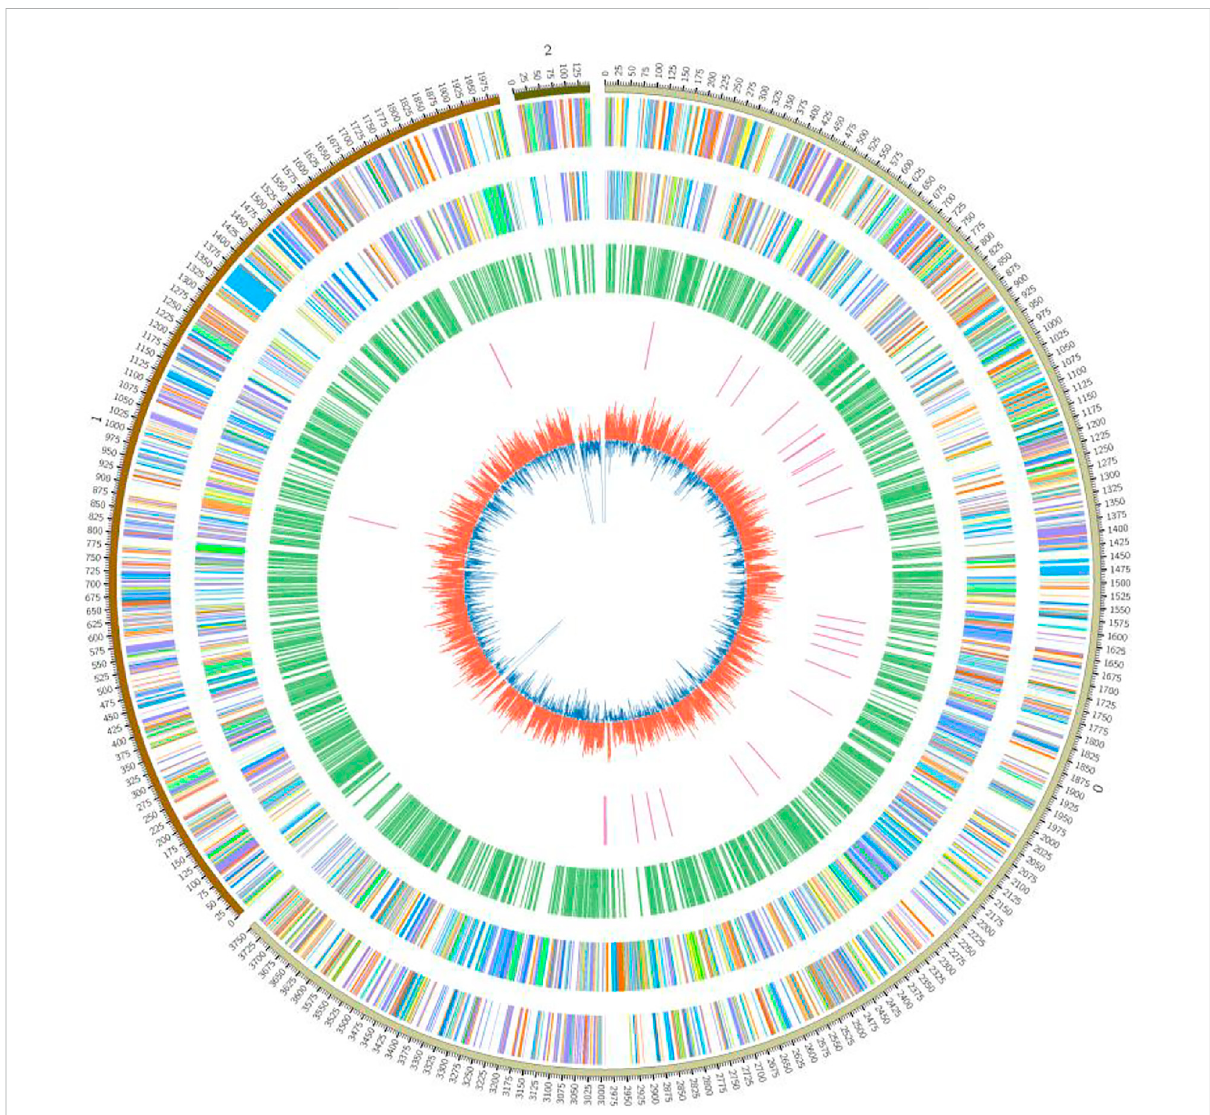
FIGURE 1 Circular map showing the genome of the R. solanacearum strain FJ1003. The outermost circle indicates the marker of genome size, with each scale of0.1Mb; thesecondand thirdcirclesindicatethegenesonthepositive andnegativestrandsofthegenome, respectively, and differentcolors represent the different functional categories of COG; the fourth circle represents repetitive sequences, and the fi fth circle is tRNAs. The innermost layer indicates the GC